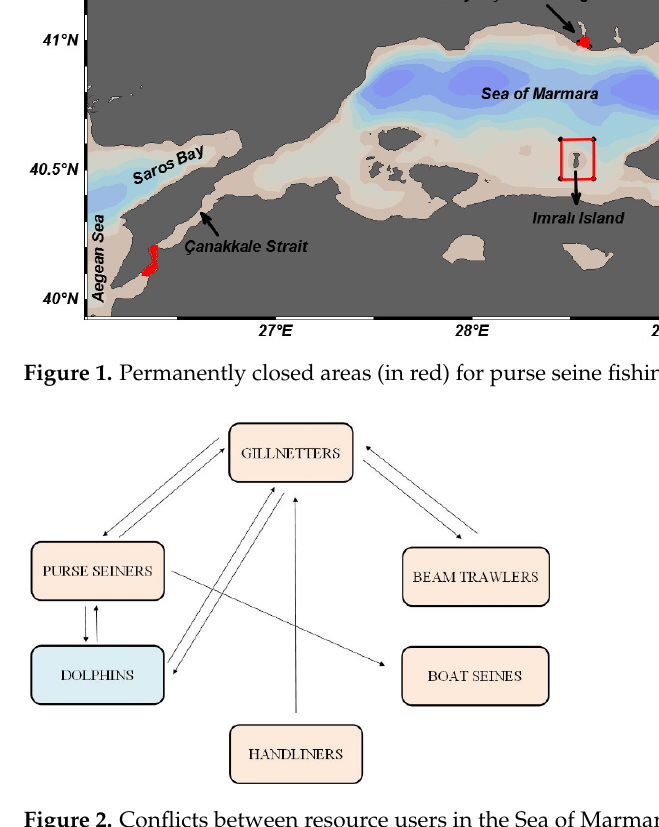
Figure 1. Permanently closed areas (in red) for purse seine fishing in Marmara Sea.